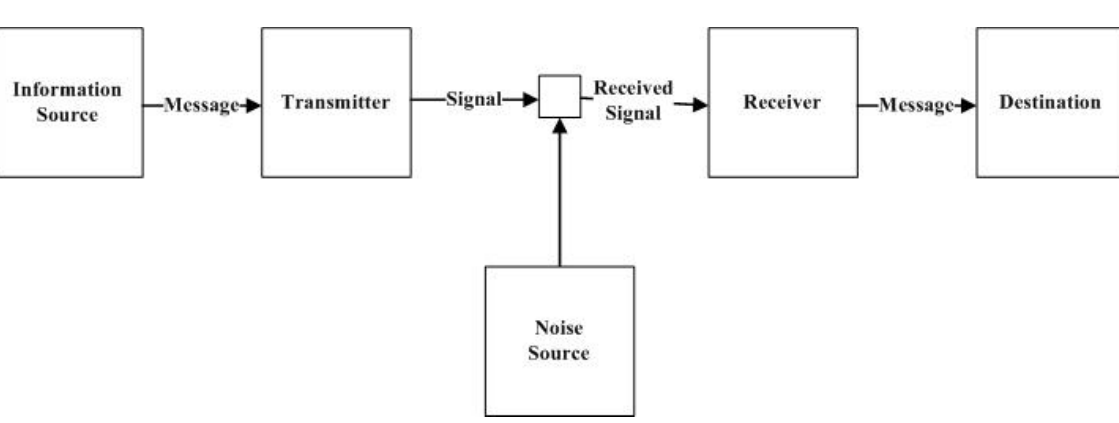
Figure 3 Schematic diagram of a general communication system (Shannon 1948)